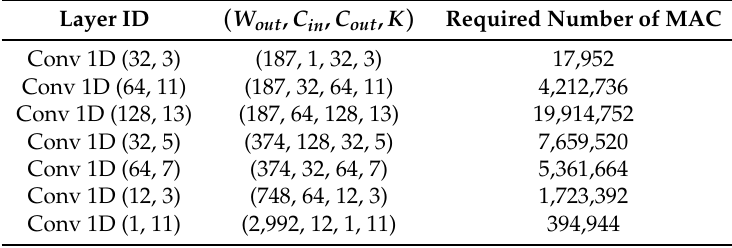
Table 9. The number of MAC of the deep convolutional layers at the decoder side. Layer ID ( W out , C in , C out , K ) Required Number of